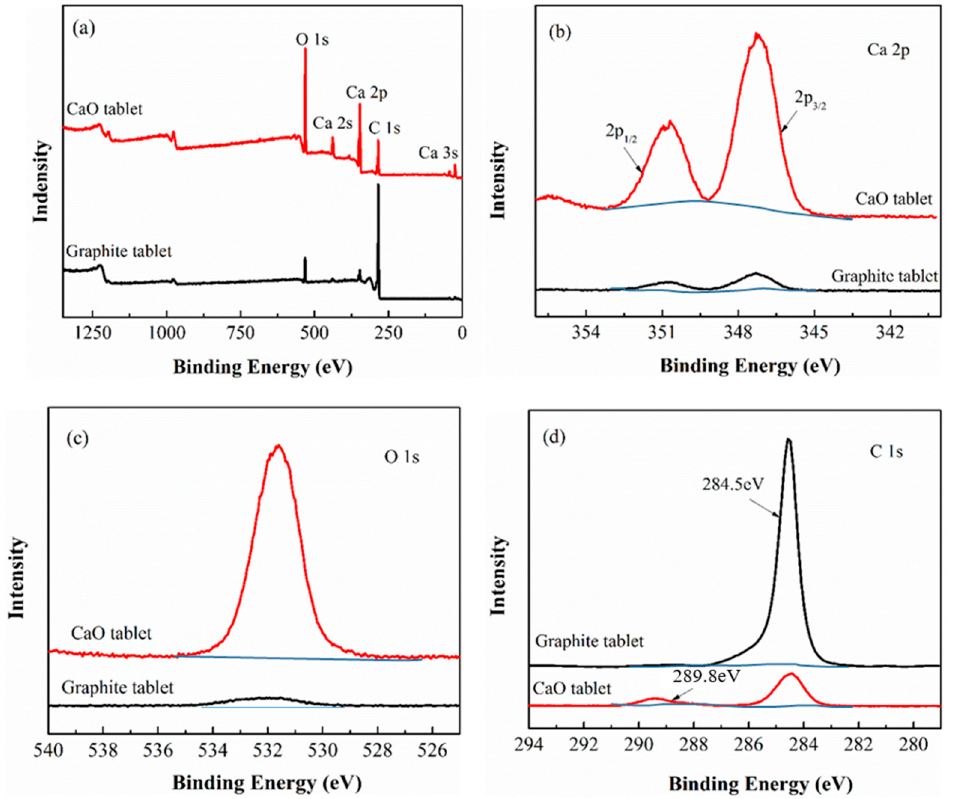
Figure 6. XPS spectra of the microwave-heated CaO and graphite pellets at 1470 °C. ( a ) Survey spectrum, ( b ) high-resolution Ca 2p spectrum, ( c ) high-resolution O 1s spectrum, ( d ) high-resolution C 1s spectrum.